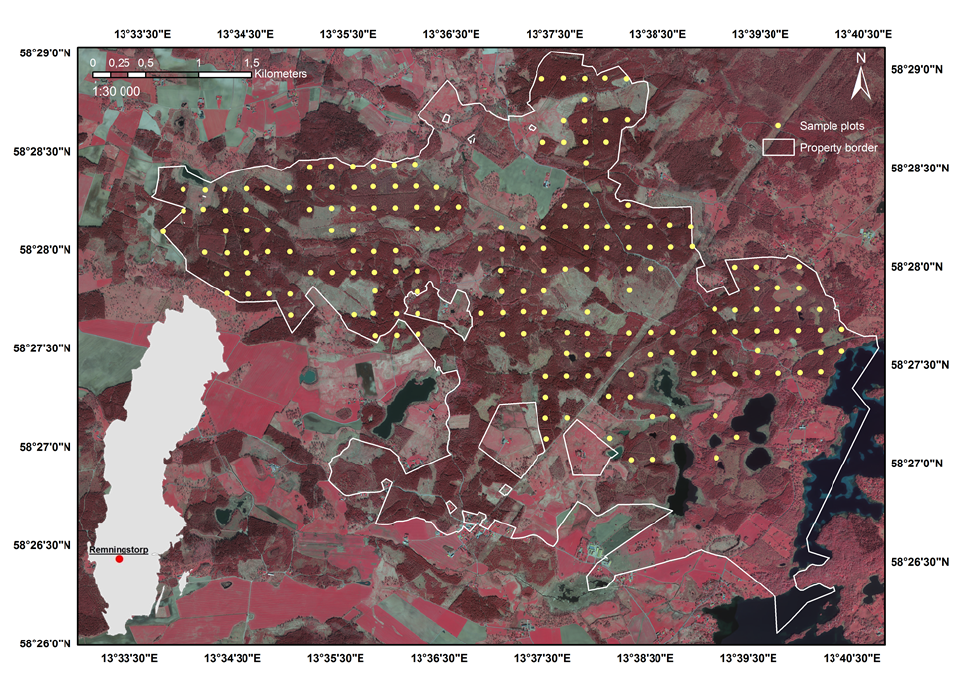
Figure 1. The map shows the sample plots on the test site Remningstorp, with a basemap of a false color ortophoto. In the lower left corner, the location of the test site is illustrated with a red dot on a map of